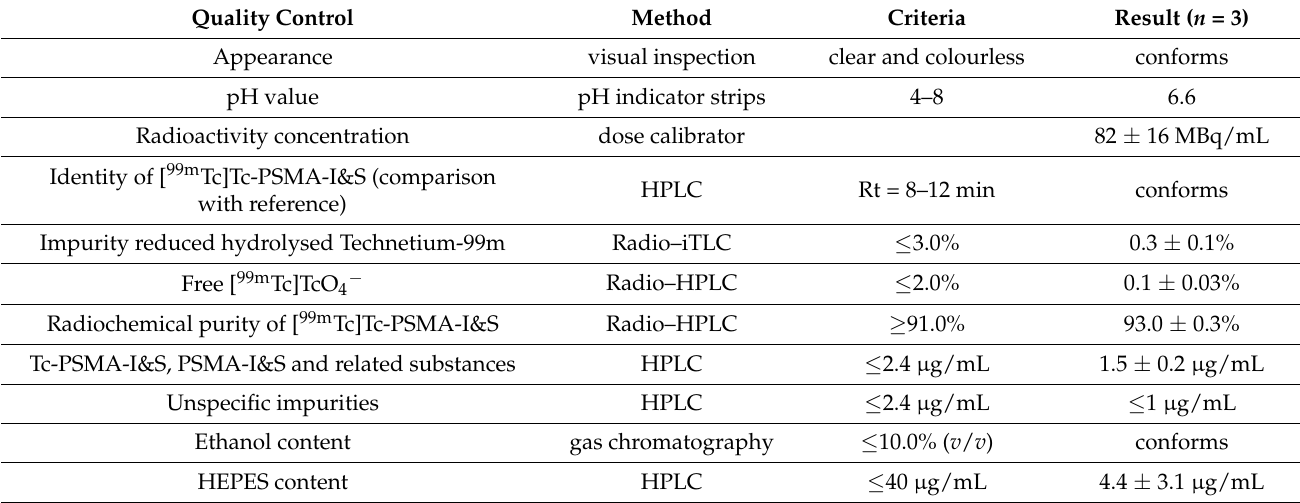
Table 2. Results of the quality control of 3 masterbatches of [ 99m